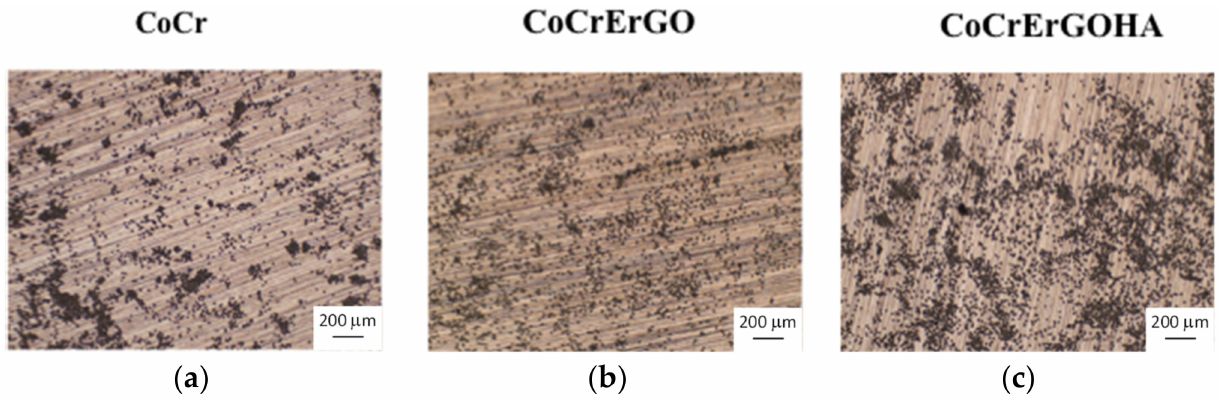
Figure 4. Optical microscopy: Pattern distribution of macrophages J774A.1 on CoCr ( a ), CoCrErGO ( b ), and CoCrErGOHA ( c ) discs after 72 h in